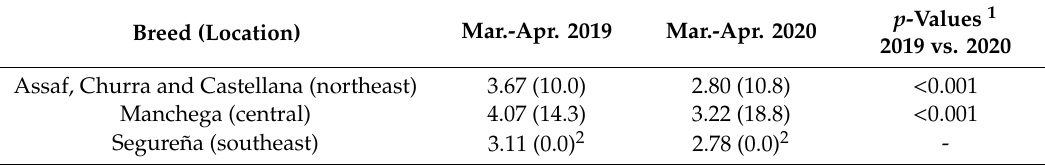
Table 1. Average monthly price per kilogram of lamb (EUR / kg) reported by producers for March–April 2019 and 2020 (coe ffi cient of variation, %) according to breed and location, with interannual comparisons. Data from 31 sheep flocks.